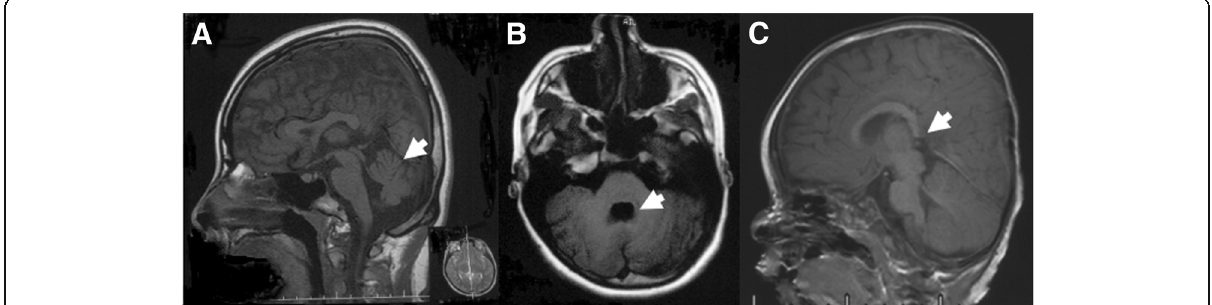
Fig. 1 Brain abnormality of Patient 1 and Patient 10. ( a , b ) T1 weighted image of Patient 1 examined at the age of 15 years showed cerebellar vermis dysplasia ( a ) and fourth ventricle deformity ( b ). ( c ) T1 weighted image of Patient 10 examined at the age of 9 months showed dysplasia of the splenium of corpus